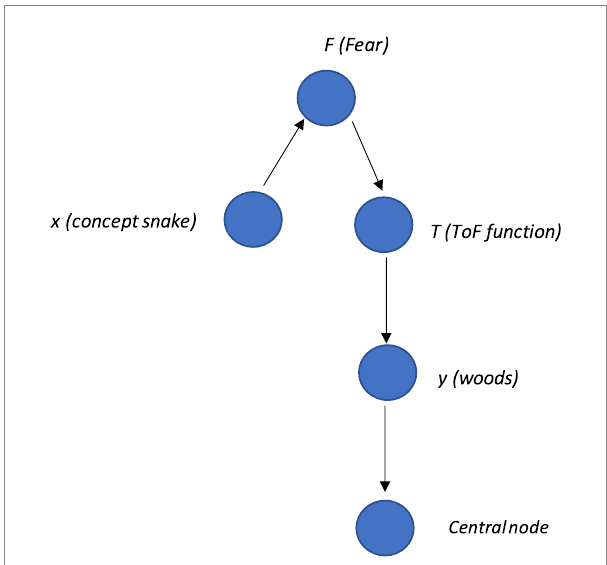
FIGURE 4 The basic schematic of the graph, whereby snake node x is framed with fear node F (illustrating the function of the snake as fear), and connecting with the computational function node T that expresses the ToF from fear F of snake x to local woods y . In addition, one central node receives input from the whole community, including a ToF between two